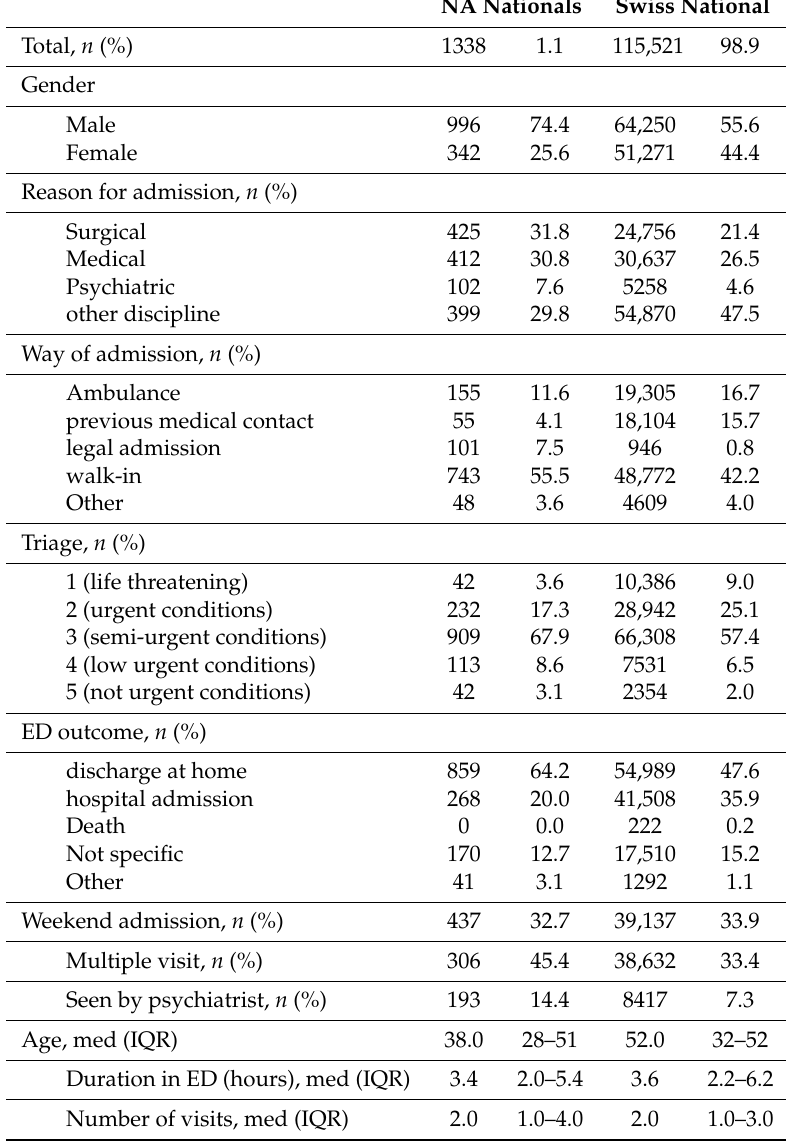
Table 1. Characteristics of ED consultations—comparison between Swiss and NA nationals consultations ( n =